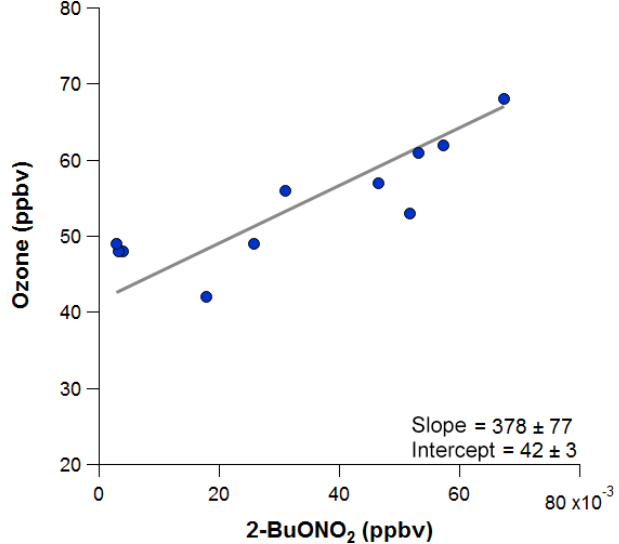
Figure 14. The orthogonal distance linear relationship of O 3 with 2- butyl nitrate during the 18 August event, when the park was clearly influenced by an air mass containing oil and gas emissions. This relationship is used in estimating the excess O 3 produced due to oil and gas